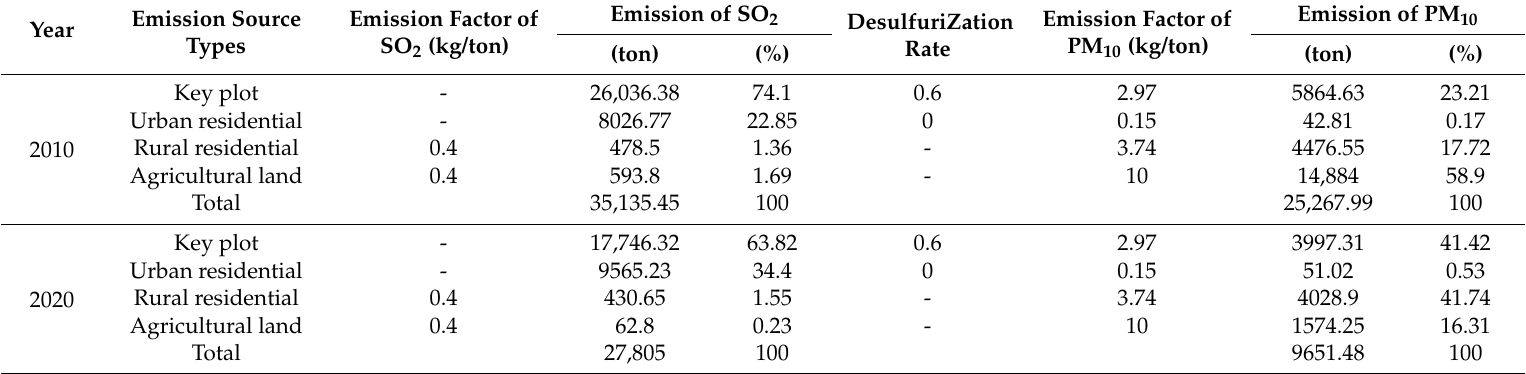
Table 1. Emission inventories of SO 2 and PM 10 from land-use point and area sources in